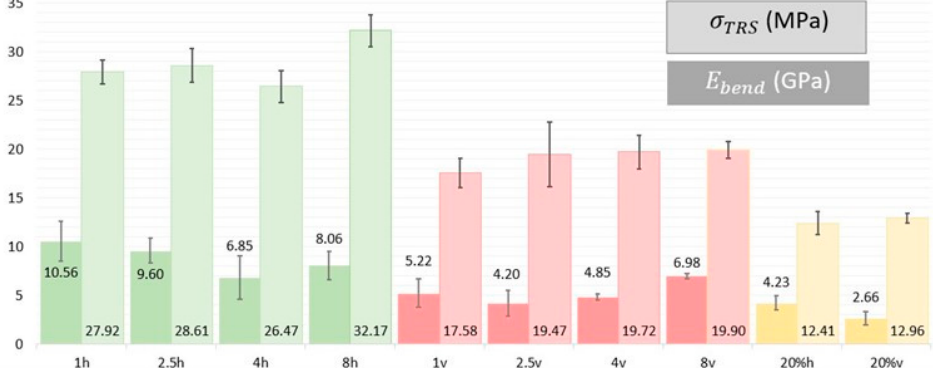
Figure 10. Average transverse rupture strength ( σ TRS ) and modulus of elasticity in bending ( E Bend ). Darker bars indicate the average E Bend , and lighter-colored bars indicate the average σ TRS